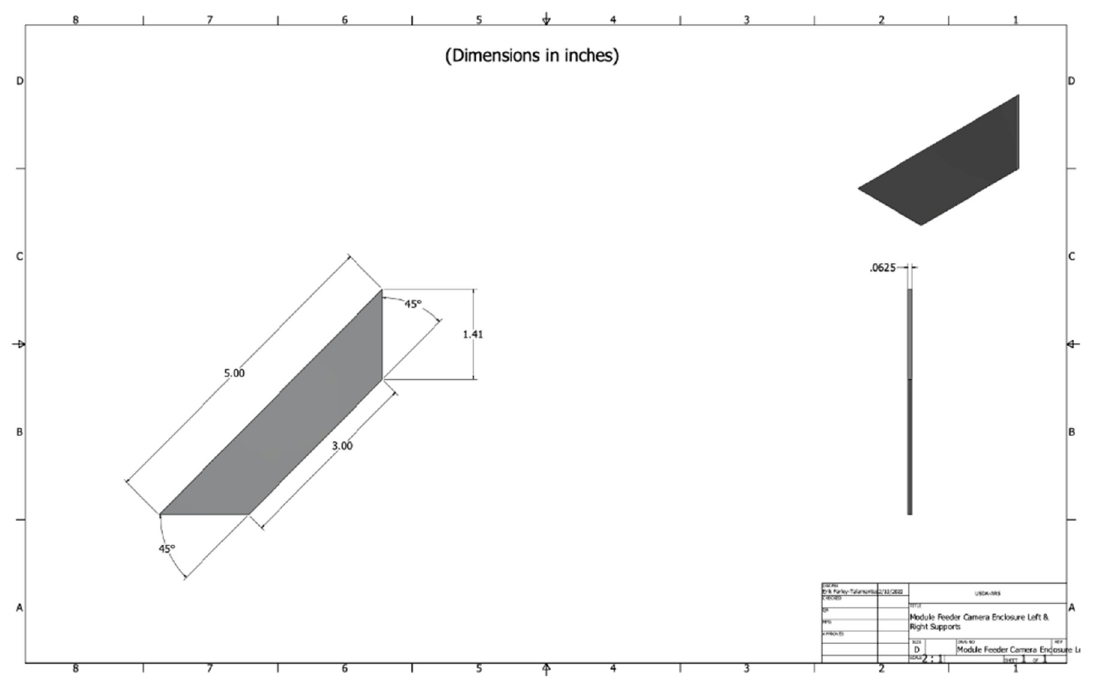
Figure 13. Module feeder camera housing enclosure support straps (#5 of assembly drawing; x2).